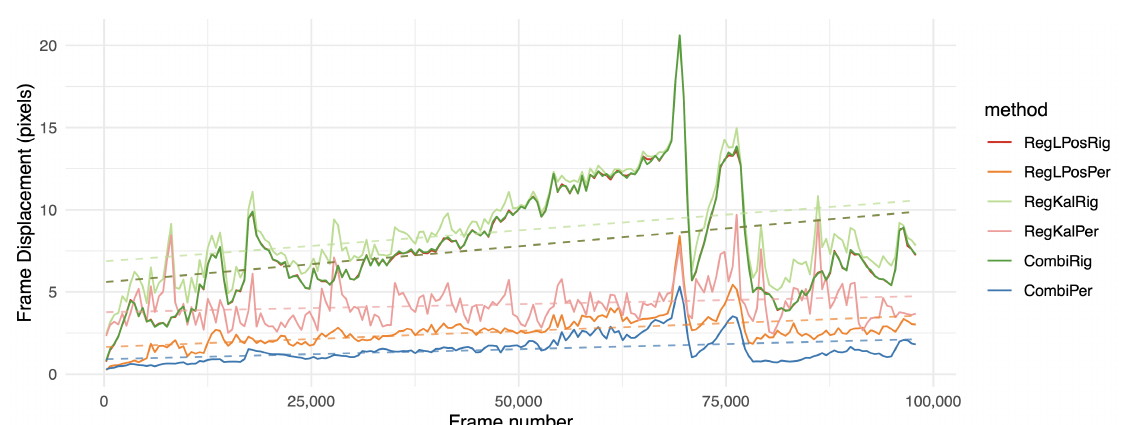
Figure 6. Frame displacement ( fd ) indicator over time on the MFull sequence; the lower the position on the graph, the better. Values were aggregated by averaging on intervals of approximately 500 frames. For more clarity, we left out the less relevant methods. The dashed line shows the result of a linear regression over the whole sequence.